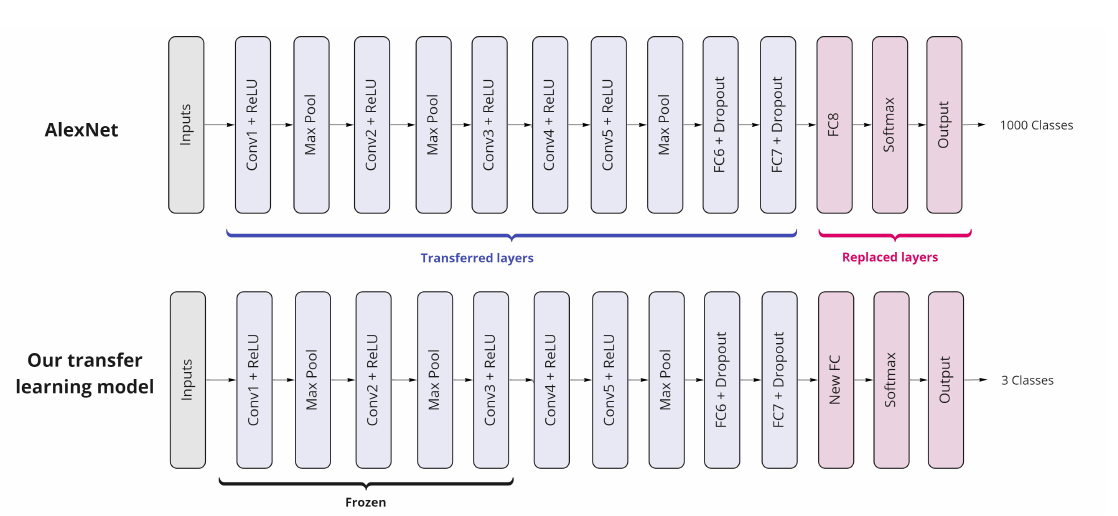
Figure 6. The structure of the transfer learning